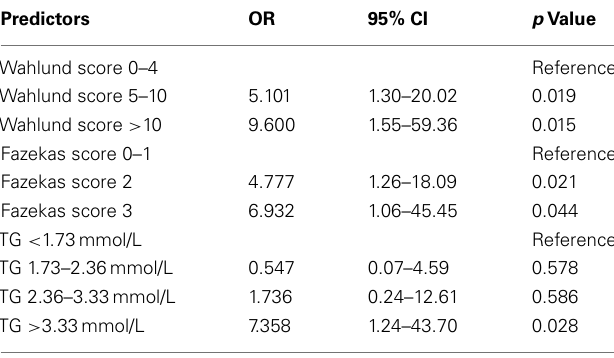
Table 2 | Results from forward stepwise binary logistical regression analysis assessing risk factors for cavitating